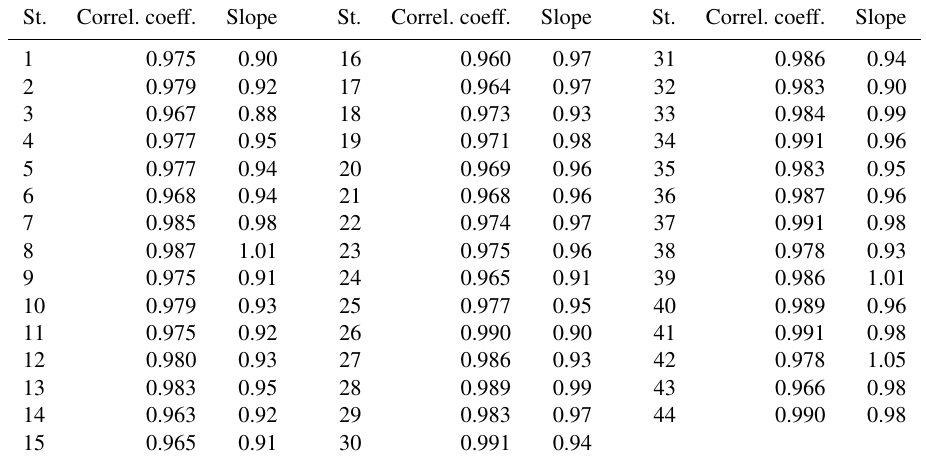
Table 8. Correlation coefficients (Correl. coeff.) and slopes of the least-squares fitting lines at each station for G . St. Correl. coeff. Slope St. Correl. coeff. Slope St. Correl. coeff. Slope